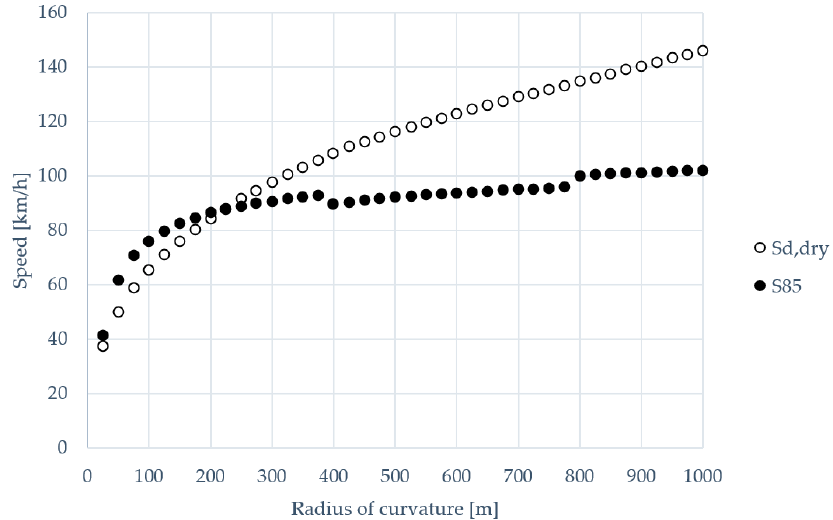
Figure 6. Maximum inferred design speed S d (Equation (10)) in dry conditions plotted with the 85 th operating inferred speed S 85 (Equation (3)) against the radius of curvature.